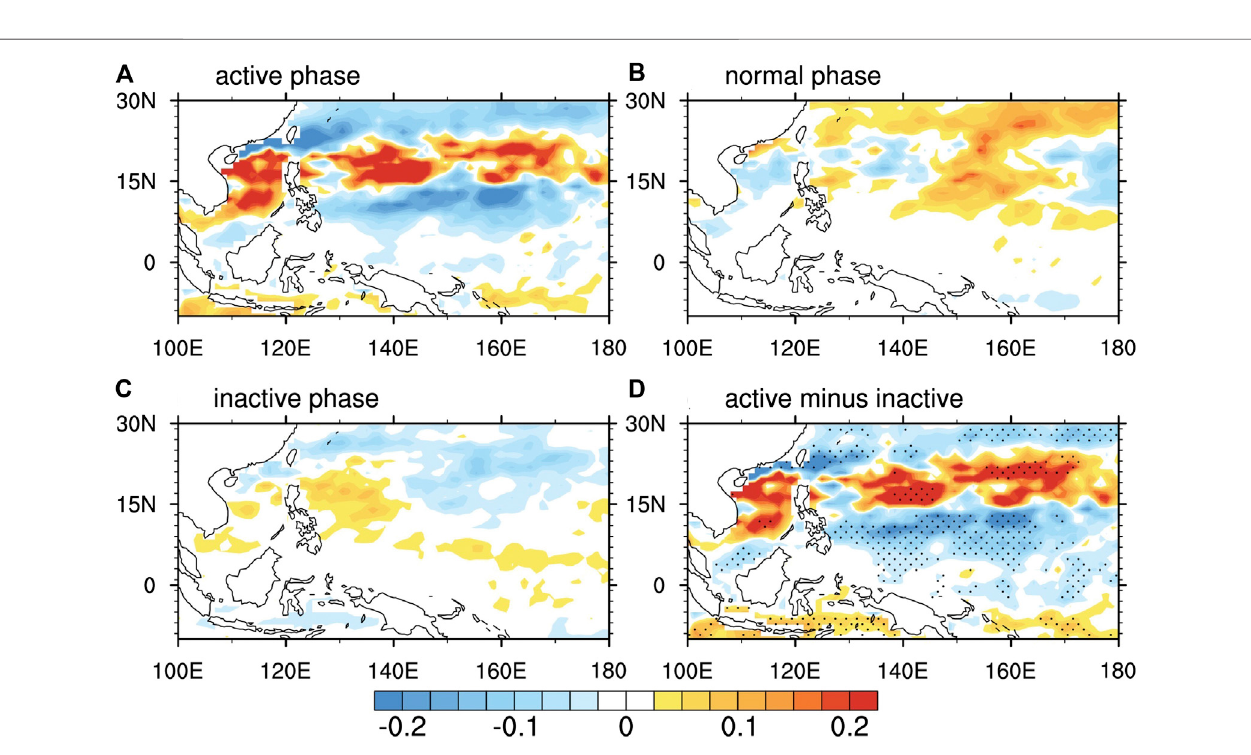
Frontiers in Earth Science |